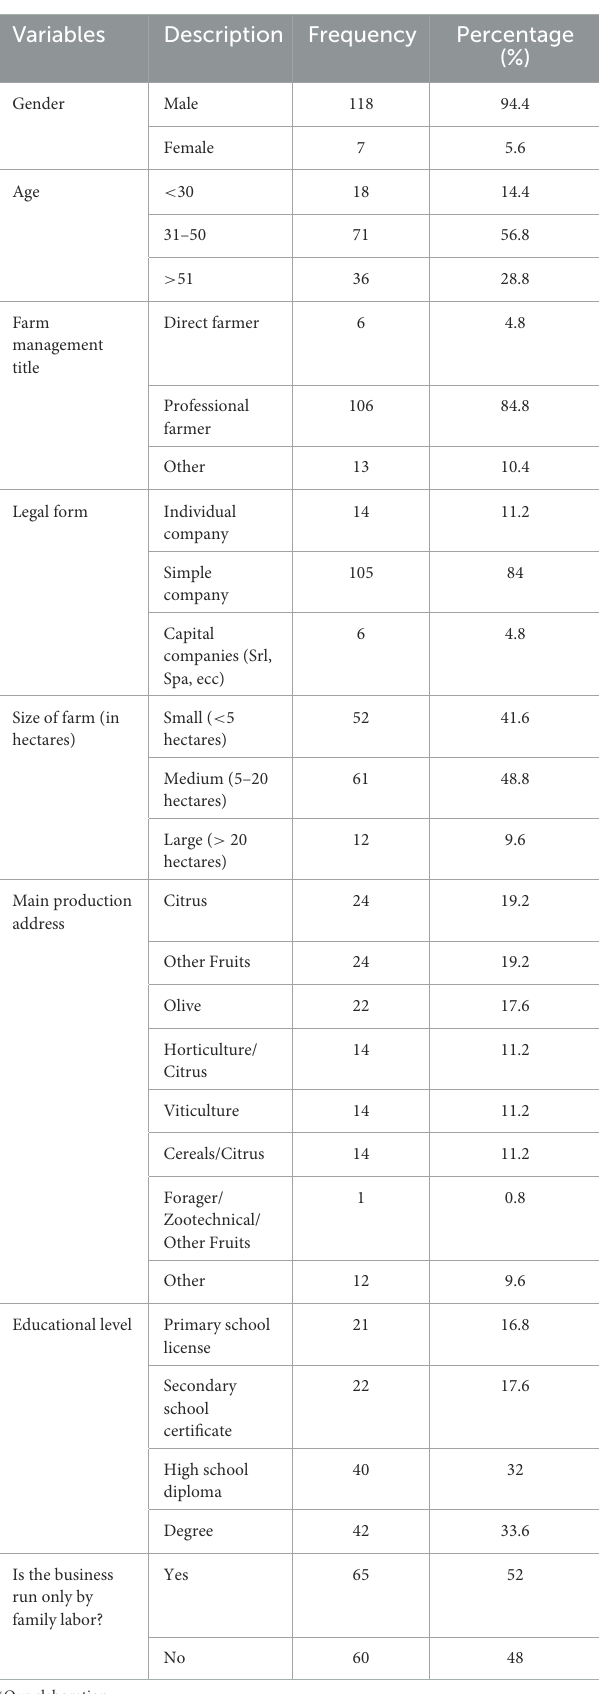
TABLE 1 Socio-economic characteristics ∗